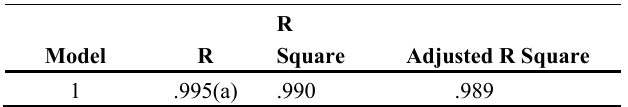
Table 10: The model summary of the linear regression analysis